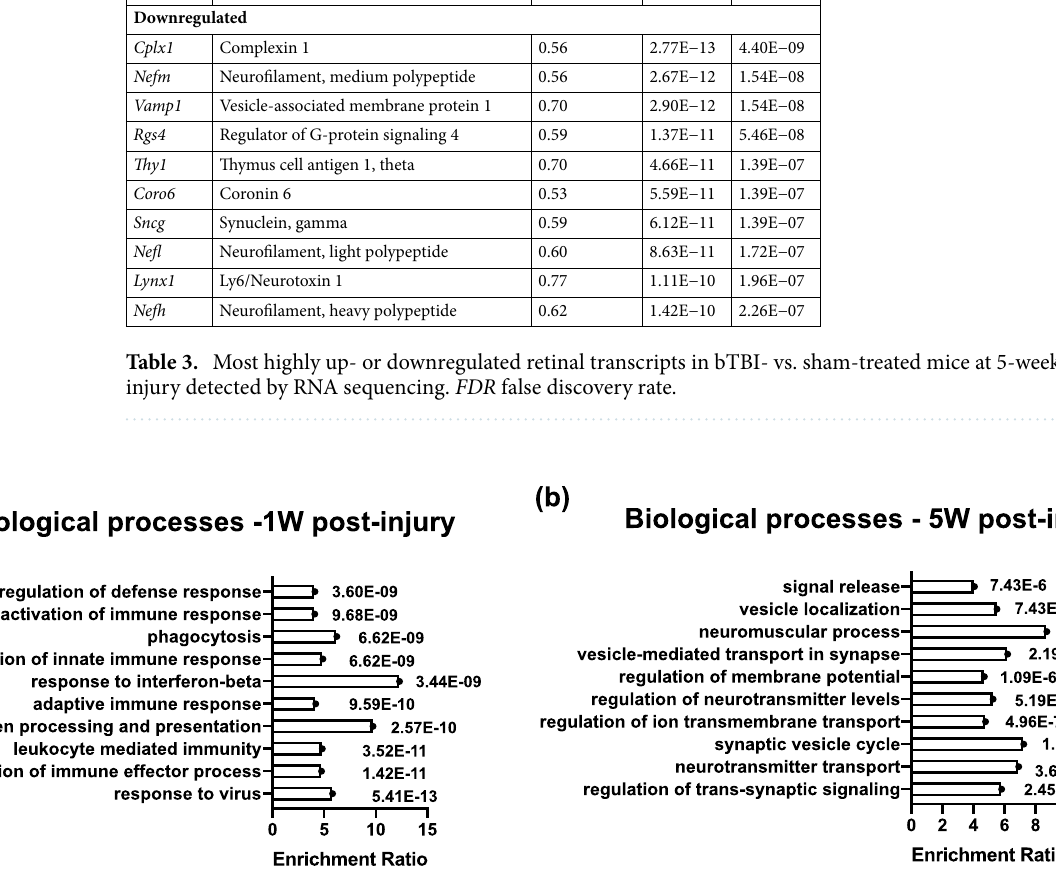
Figure 5. Transcriptomic analysis of the retina after exposure to blast with RNA sequencing. ( a ) Transcripts whose expression was significantly dysregulated at ( a ) 1 week (1 W) or ( b ) 5 weeks (5 W). Transcripts whose expression changed significantly (false discovery rate (FDR) < 0.005 for TBI compared to sham retinas) analyzed using WebGestalt, by performing an “Over-Representation Analysis” using the gene ontology database for “Biological Process noRedundant” analysis. The false discovery rate (FDR) for each process is indicated. The graphs were generated using WebGestalt 2019 109 and the figure was assembled in Adobe Illustrator CC